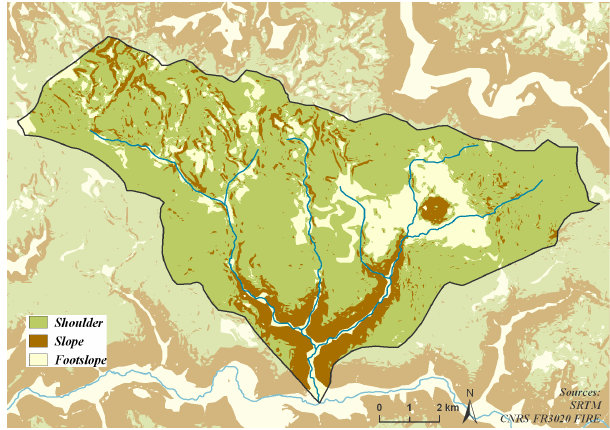
Fig. 2. Topographical map of the Orgeval